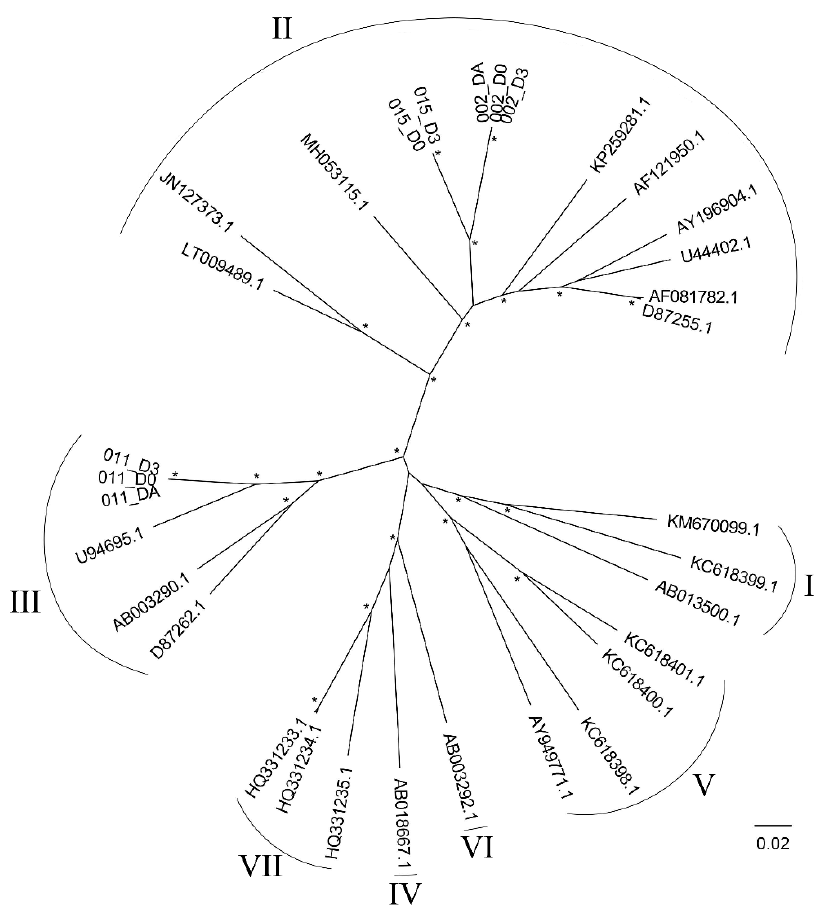
Figure 3. Maximum likelihood phylogenetic tree of Human pegivirus-1 (HPgV-1), genotypes 1 to 7. The phylogenetic tree was reconstructed by using IQ-TREE 1.6.12 [27] with the best-fit nucleotide substitution model (GTR + F + I + γ4) under the Bayesian information criterion. SH-aLRT and ultrafast bootstrap branch support was computed based on 10,000 bootstrapped trees. Genotypes of the viruses are indicated by Roman numerals. Asterisks (*) signify high ( ≥ 90%) bootstrap supported nodes. The scale bar is in the units of nucleotide substitutions per